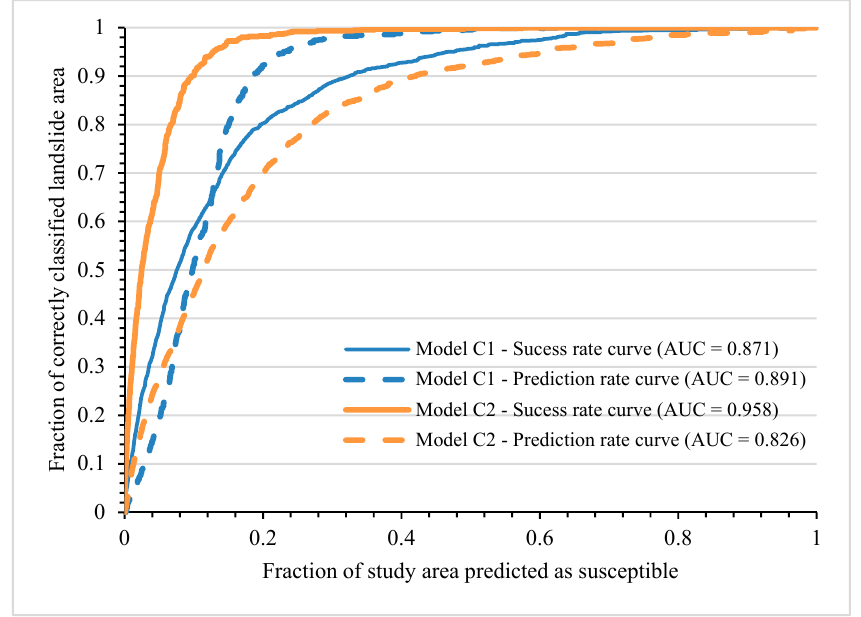
Figure 14. Success and prediction rate curves of landslide susceptibility Models C1 and C2.